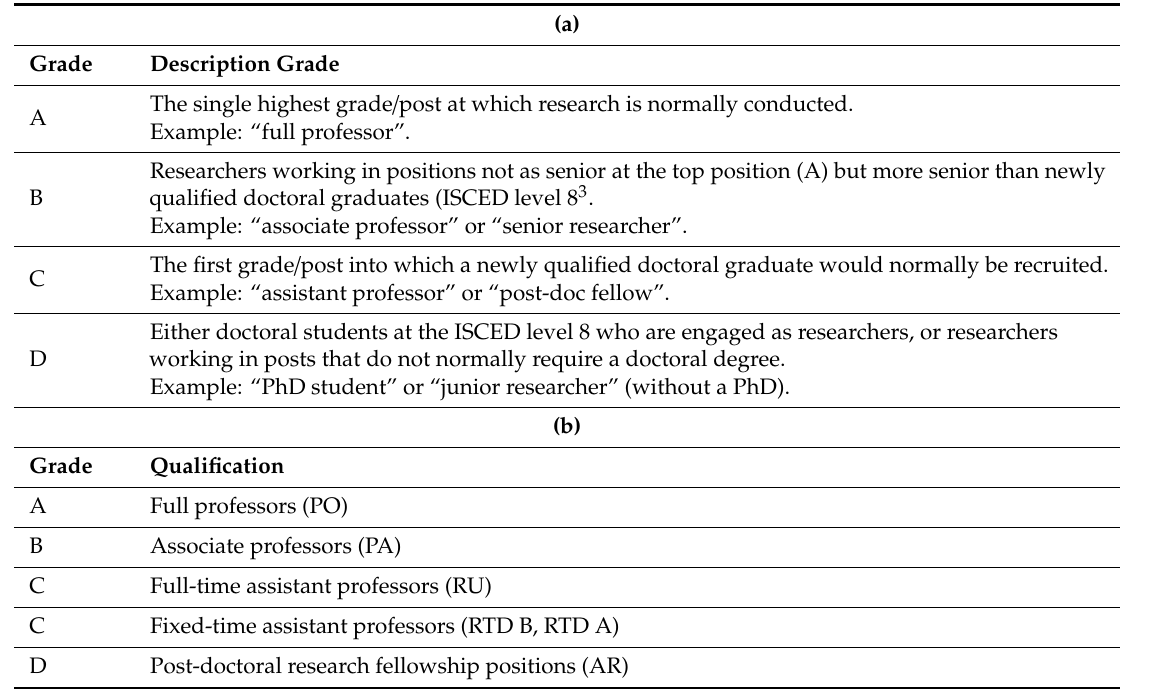
Table 1. Grades of academic career: ( a ) Definitions of academic grades provided by Frascati Manual (2015), ( b ) decoding the classification used by the MIUR (Source: MIUR definition 2